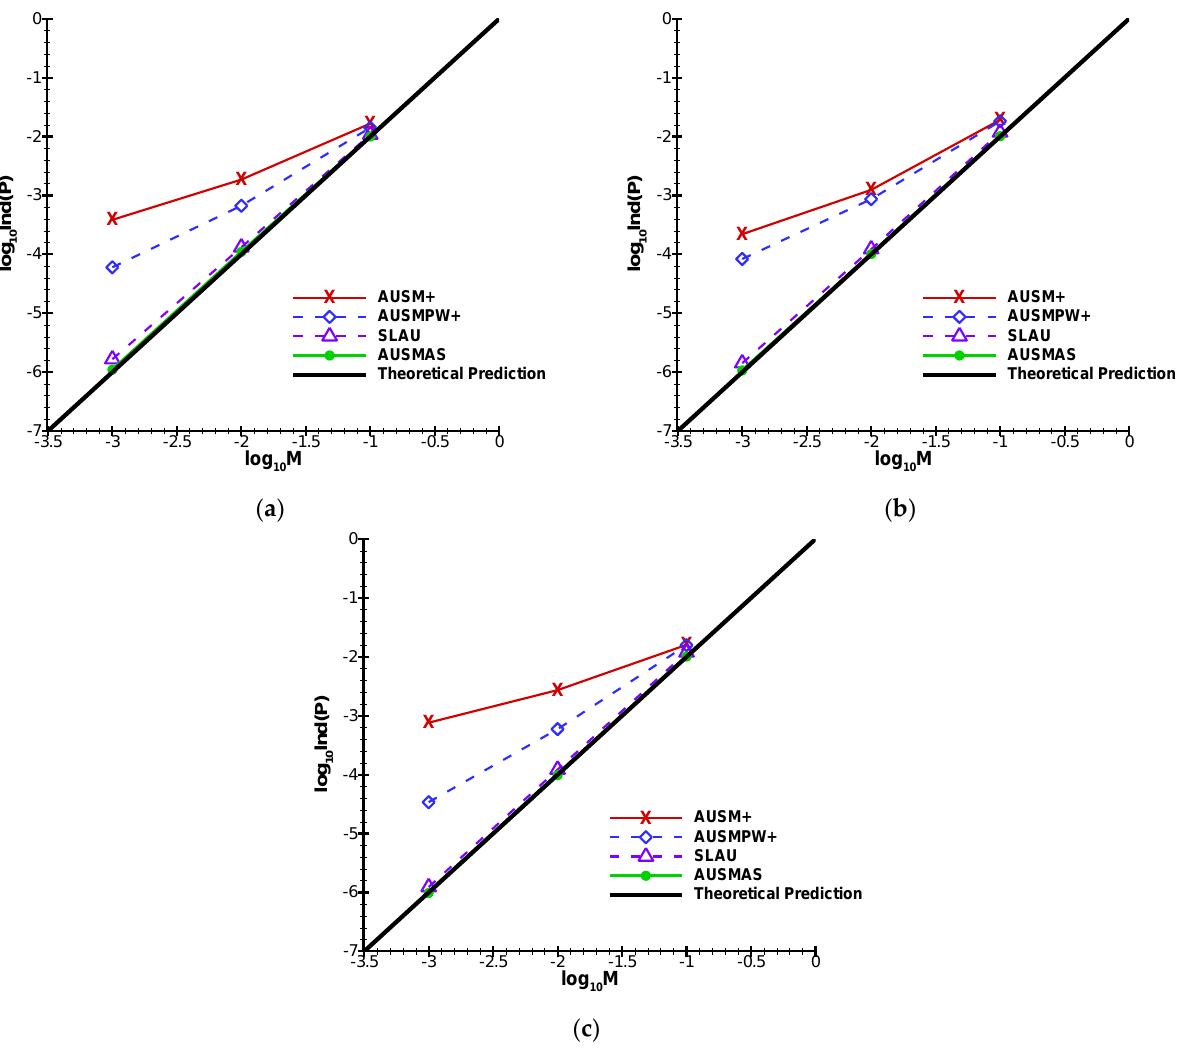
Figure 12. Pressure fluctuations vs inflow Mach number (coarse grid, ( a ) first order reconstruction, ( b ) second order reconstruction, ( c ) third order reconstruction).